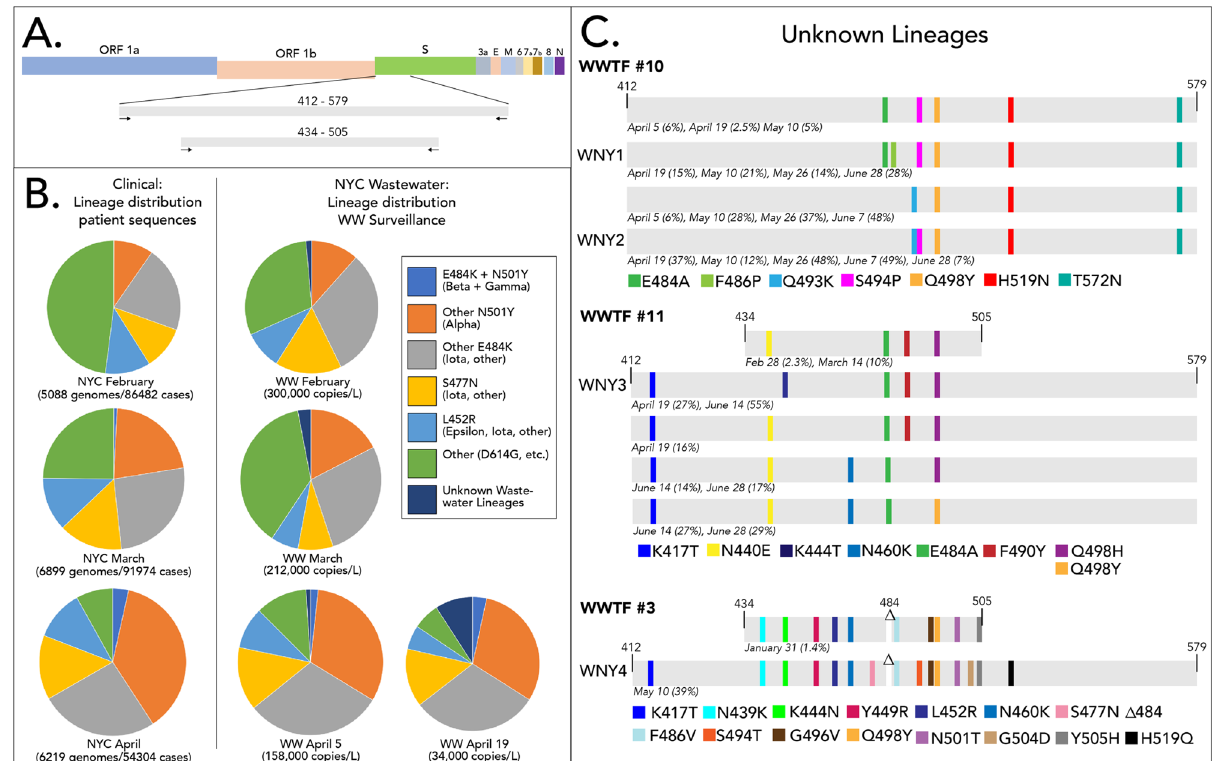
Fig. 1 Novel SARS-CoV-2 lineages from wastewater. A Schematic of SARS-CoV-2 and the ampli fi cation locations. B Distribution of SARS-COV-2 variants based on patient sequences (patient data obtained from GISAID) and wastewater surveillance. Polymorphisms detected from amplicon sequencing that were used to assign sequences to lineages are shown in the legend. The variants detected from the 14 NYC WWTPs were weighted by fl owrate to generate a city-wide average distribution. C Novel lineages detected from WWTPs. Schematic highlights shared sequences identi fi ed from WWTP 10, 11, and 3 are shown. The percent of the sequences from each date that contained the indicated polymorphisms is shown below each lineage. The viral copies/ L corresponding to each date are shown in Supplementary Table 3. Some sequences have additional polymorphisms not listed. WNY lineage designations are shown for sequences used for tropism and antibody neutralization analysis. Source data are provided as a Source Data fi